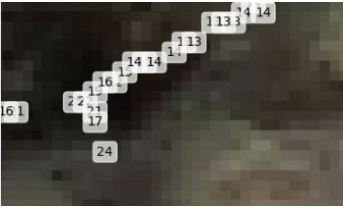
Figure 13. The number of measured widths along the crack. The automatically detected number of pixels, calculated widths, and absolute error rates are listed in Tables 9 to 11.